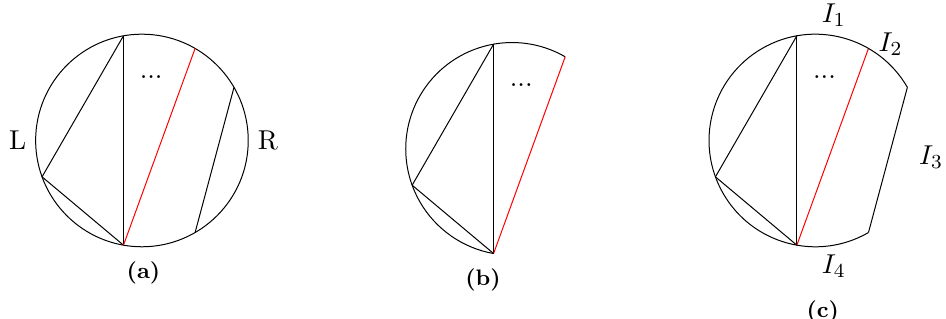
2 ) ( L, R | L 0 , R 0 ) . The factor- r 2 ) ( I L , L | I L , L 0 ) . (c): an intermediate | L | +1